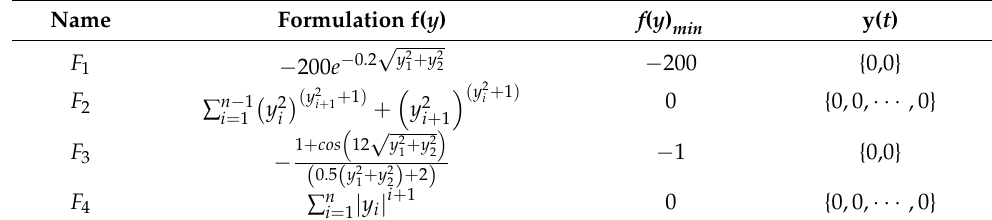
Table 1. Unimodal benchmark functions.